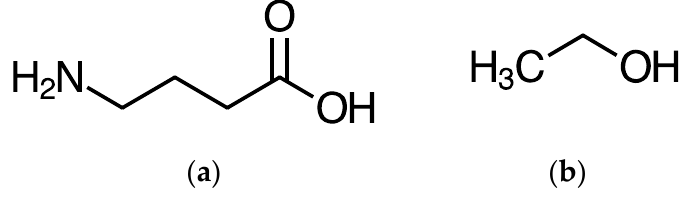
Figure 1. GABA ( a ) and ethanol (alcohol) ( b ) molecules.